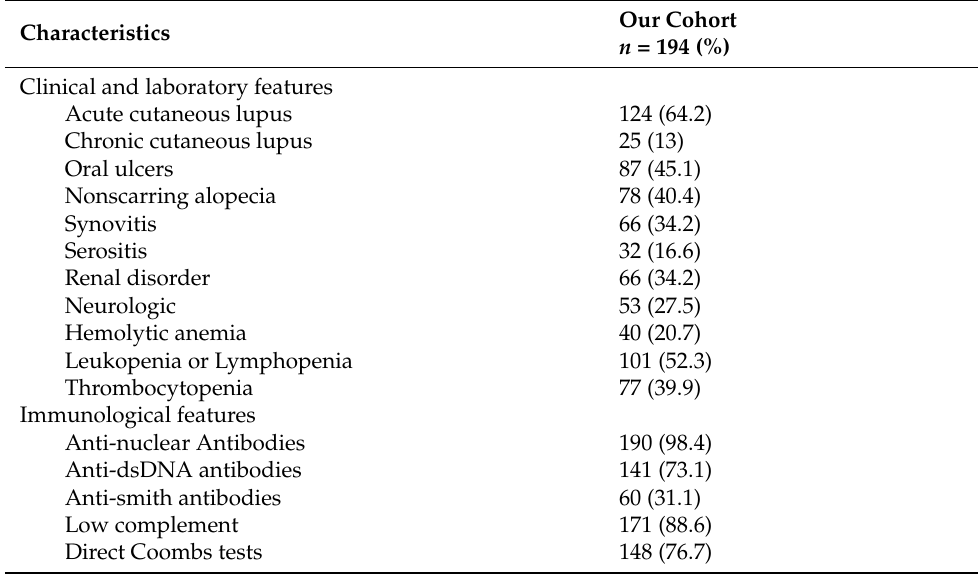
Table 3. Prevalence of SLICC Classification Criteria in jSLE cases at diagnosis.